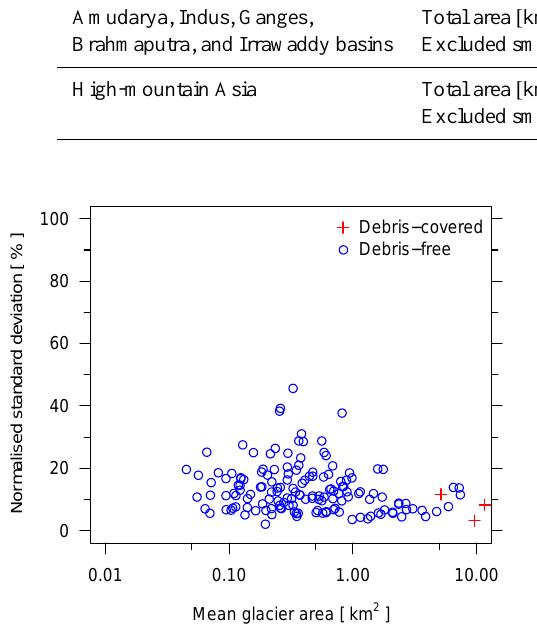
Table 1. Summary of glaciers in the GGI, ICIMOD inventory, and the RGI, excluding glaciers smaller than 0.05km 2 . The uncertainty in RGI ver. 4.0 was calculated using the error estimation equation (Eq. 1) in Pfeffer et al. (2014). GGI